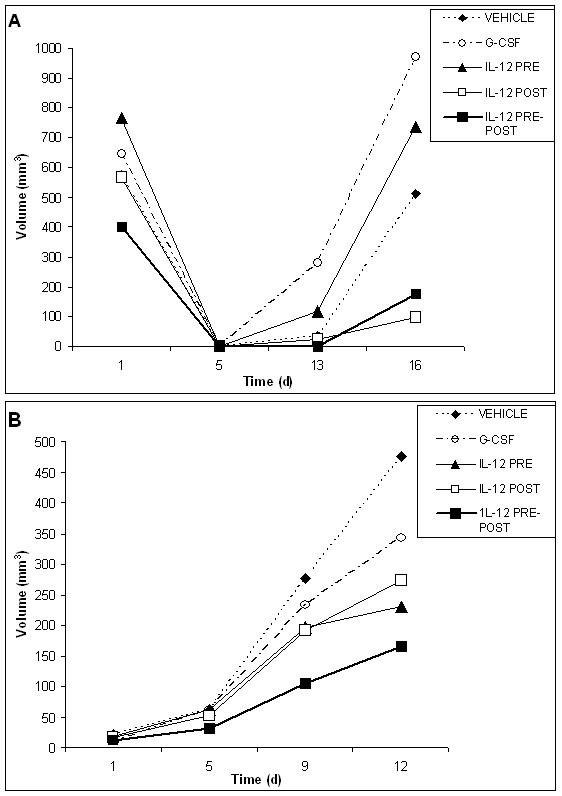
Relative changes in tumor volumes for vehicle, G-CSF, IL-12 pre-only, IL-12 post-only and IL-12 pre-post treatment groups following chemotherapy. Changes in tumor volumes over the course of the experiment are shown for the EL4 lymphoma tumor model (A) and the Lewis Lung cancer tumor model (B). IL-12 treatment significantly reduces tumor growth following cyclophosphamide treatment in late stage tumor models. In the EL4 tumor model, treatment with IL-12 pre-post or IL-12 post-only significantly reduced tumor growth (%T/C < 50%), as compared to both the G-CSF vehicle control groups at the end point of tumor growth assessments. In the Lewis lung cancer model, the IL-12 pre-post and IL-12 pre-only treatment groups yielded a significant reduction in tumor growth (%T/C < 50%), as compared to both the G-CSF and vehicle control groups at the end point of tumor growth assessments. These tumor models represent a late stage cancers, as compared with the models used for the radiation studies because tumors were apparent at the start of the treatments consisting of cyclophosphamide and cytokine therapy. In the case of the lymphoma model, therapy was initiated when the tumors were very large (about 500 mm3).